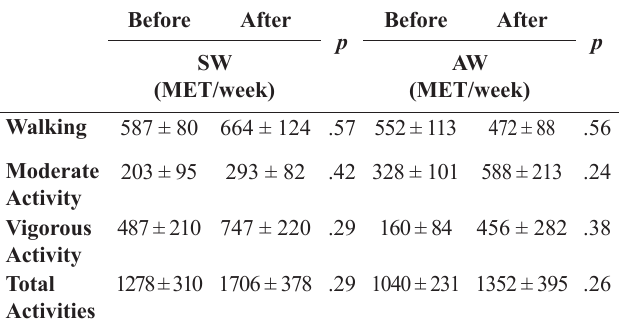
Table 2. Metabolic equivalents per week before and after the 6-month stretch break